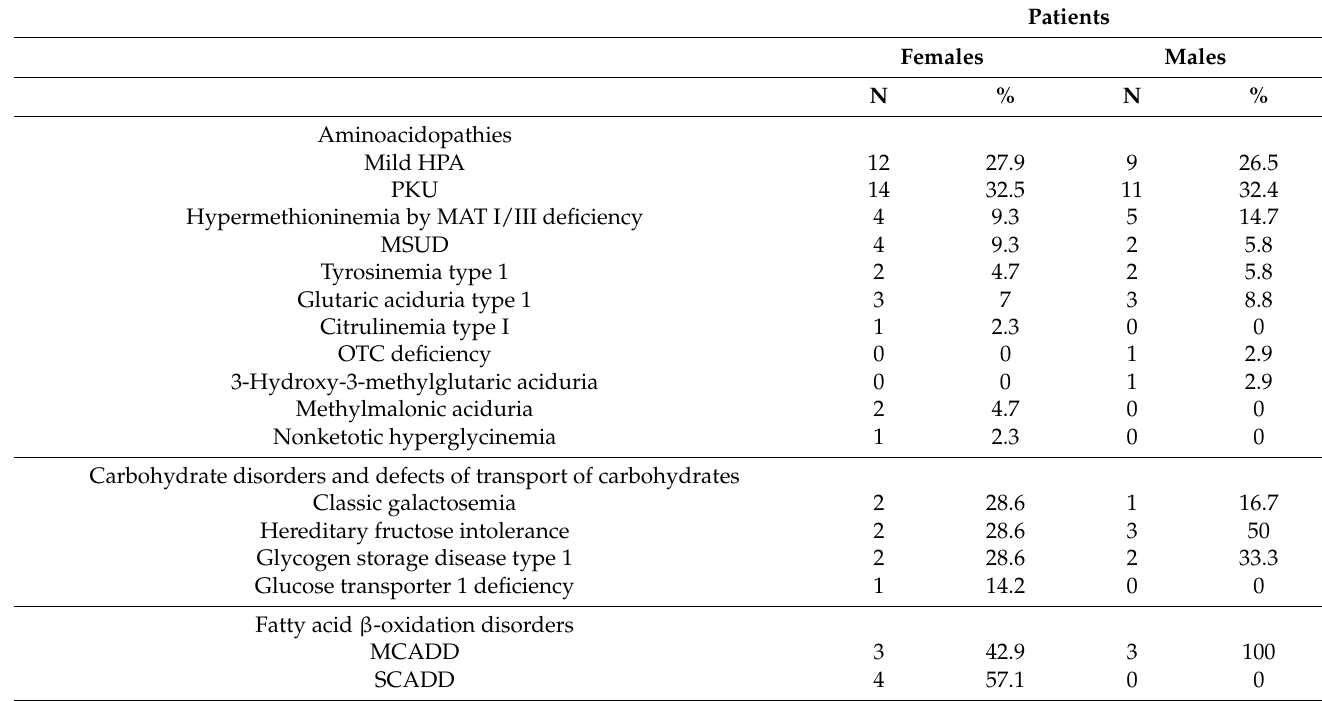
Table 1. IEIM subtypes in participating patients, according to